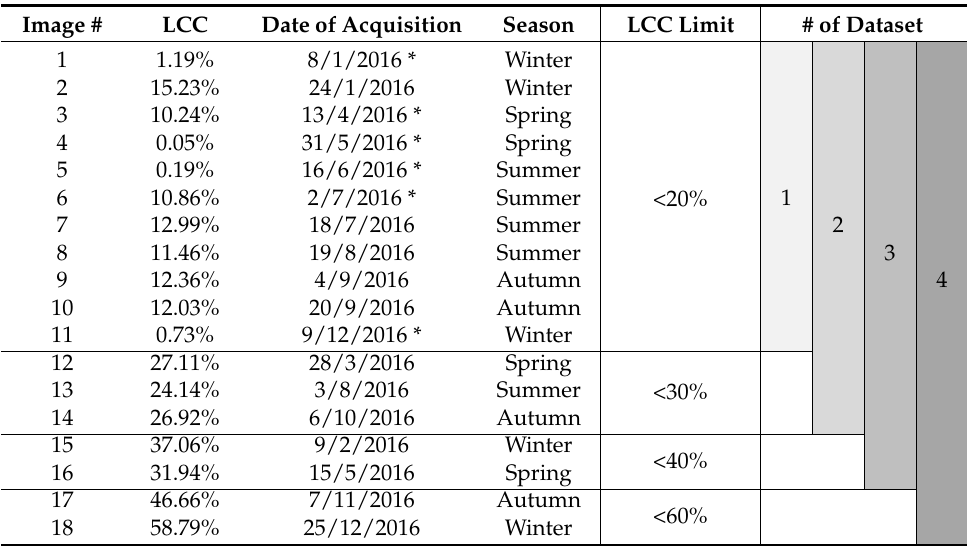
Table 1. Land cloud cover (LCC), acquisition dates and the corresponding season are presented for each image along with the LCC